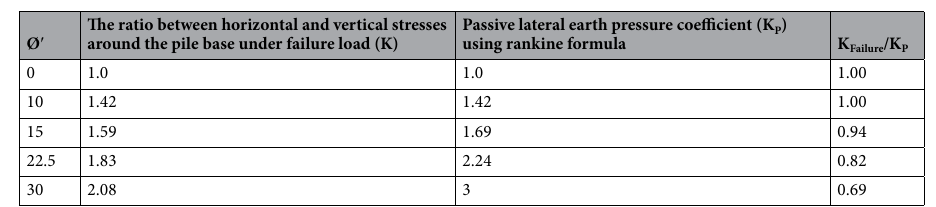
Table 2. The ratio between vertical and horizontal stresses around pile base and under failure load for different effective friction angle values.